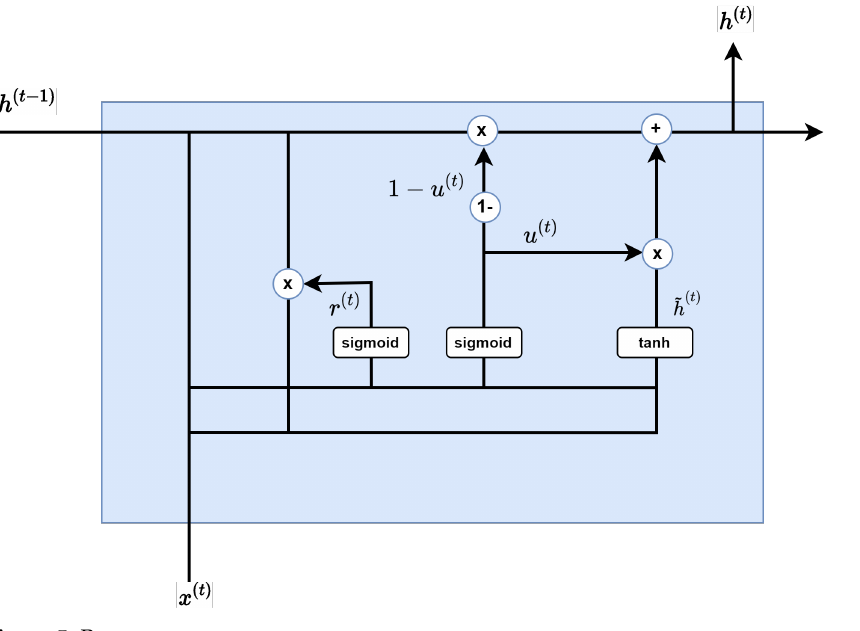
Figure 5. Reset gate.